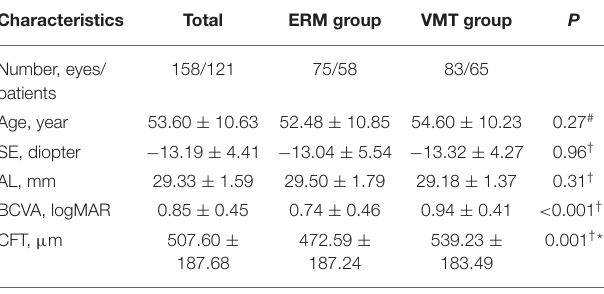
TABLE 1 | Comparation of demographics and ocular parameters between eyes with different vitreomacular interface abnormalities. Characteristics